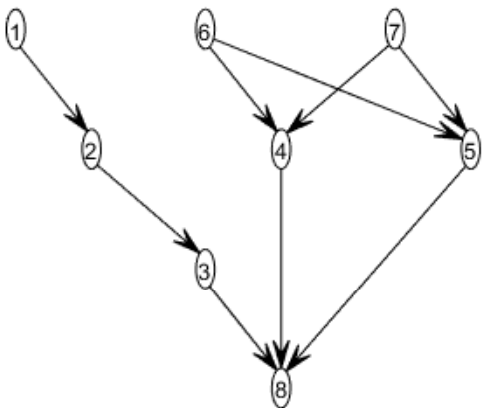
Figure 4. Network structure of the Bayesian network model for evaluating bus drivers’ mental health and traffic safety. 1 — Age; 2 — Driving experience; 3 — Somatization; 4 — Depression; 5 — Anxiety; 6 — Cyclic tendency; 7 — Lack of objectivity; 8 — Group.